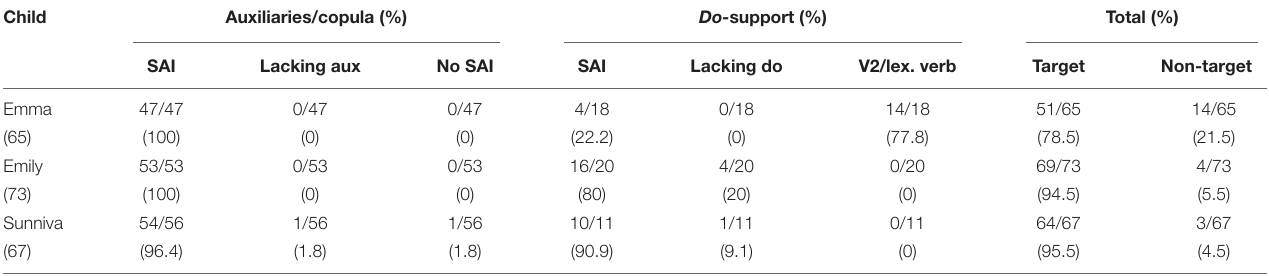
TABLE 5 | Finite verb placement in yes/no- questions (requiring SAI or do -support) in Emma, Emily and Sunniva’s files. Child